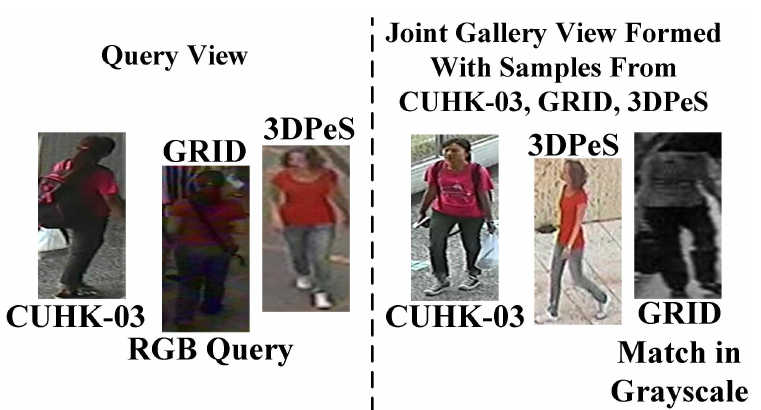
Figure 11. In the Challenging Close-Set Scenario, the Query image, the image of GRID domain could be seen in the RGB modalily (or different style), whereas its match in Gallery view has Grayscale modality.